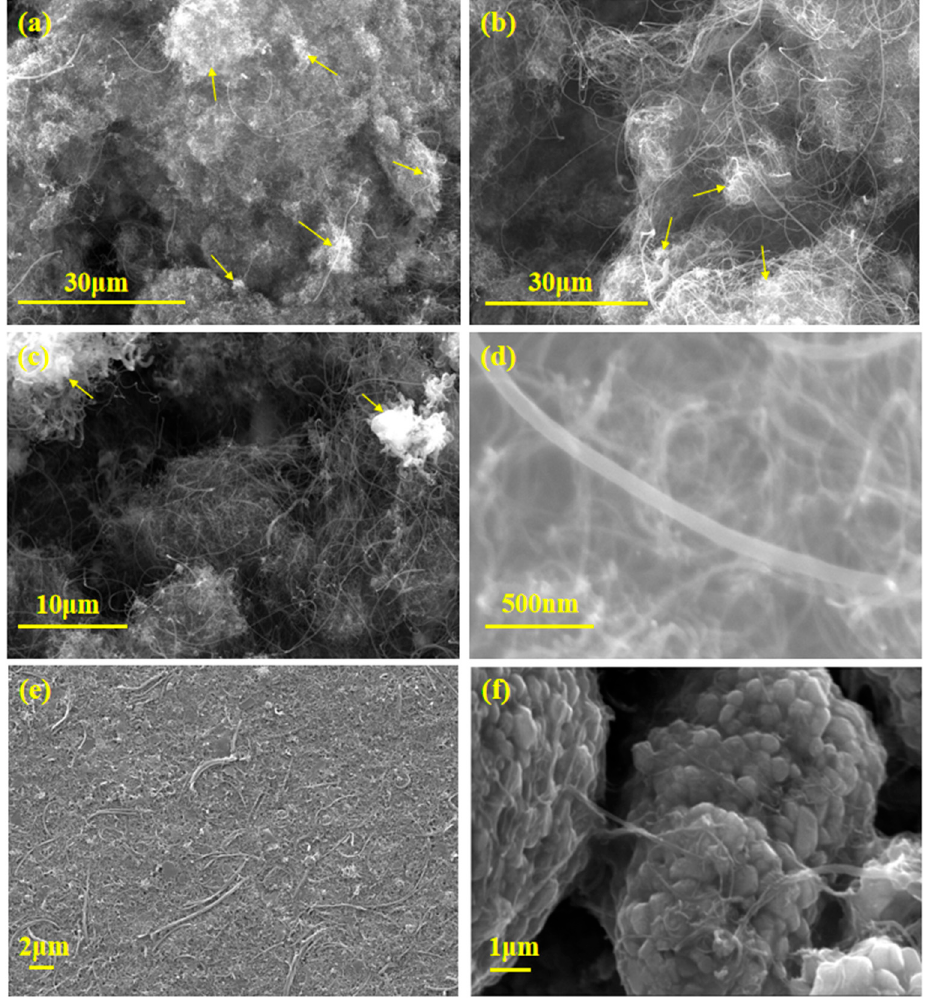
Figure 4. Characterization of MWNTs, SEM images of ( a ) undiluted MWNTs; ( b ) MWNTs annealed at 2000 ℃ ; ( c ) MWNTs annealed at 2400 ℃ ; ( d ) MWNTs annealed at 2800 ℃ ; ( e ) MWNTs after sanding and dispersion; ( f ) annealed MWNTs slurry cathode sheet.